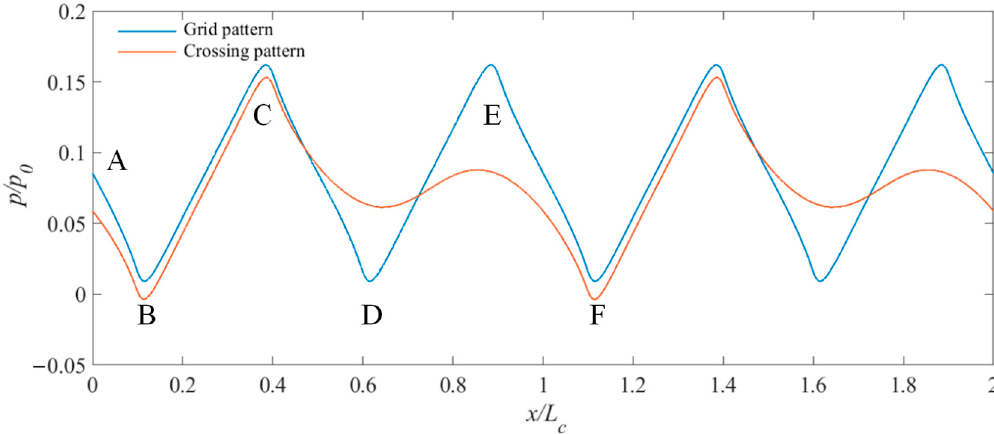
Figure 20. Static pressure distribution along the middle plane of the workpiece .